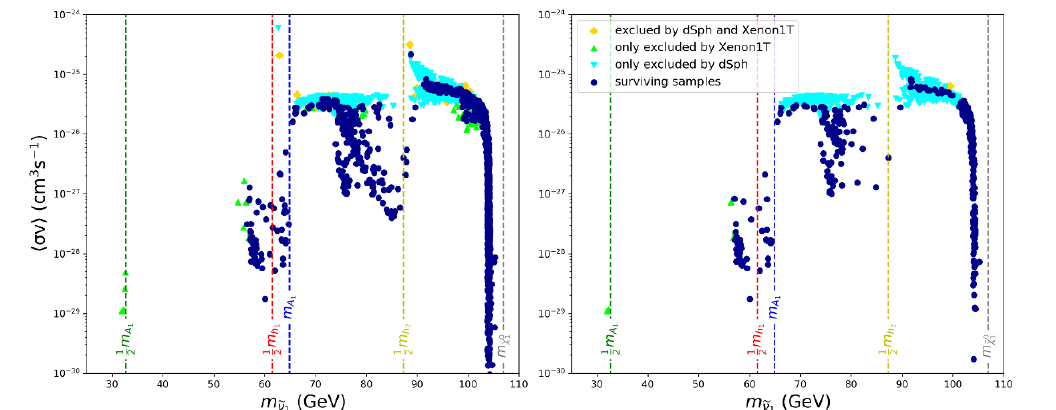
Figure 2 . Left panel: samples obtained from the scan with the constraints listed in the text considered, which are projected on h (cid:27)v i 0 (cid:0) m ~ (cid:23) plane. We use the dark blue color to represent the 1 samples that satisfy both the dSph constraint and the XENON-1T constraint, and the lime color, the cyan color and the golden yellow color to denote those which are exclude by either the XENON- 1T constraint or the dSph constraint, or the both respectively. Samples around the green, red and yellow vertical lines annihilated in early Universe through the resonant A 1 , h 1 and h 2 respectively, and those near the gray line obtain the correct relic density mainly by the annihilation of the higgsinos. For the samples close from left to the blue line, the annihilation channel ~ (cid:23) 1 ~ (cid:23) 1 ! A 1 A 1 opens up in the early Universe, and soon becomes the dominant one with the increase of m ~ (cid:23) up to 1 about 100 GeV. Right panel: similar to the left panel except that we further impose the constraint of Y (cid:23) v u = ( (cid:21) N v s ) < 0 : 1 on the samples, which is motivated by the limitations from the non-unitary of neutrino mixing matrix and the electroweak precision data.